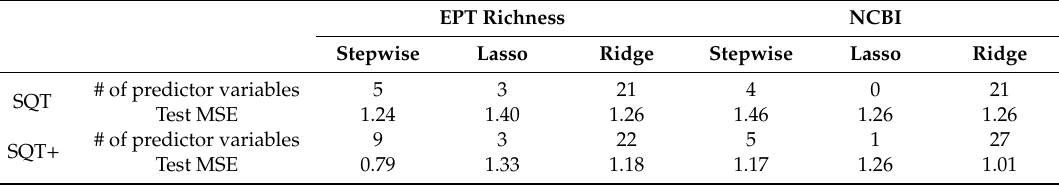
Number of predictor variables and test mean square error (MSE) results following cross-validation of stepwise, lasso, and ridge models used to predict EPT richness and the NCBI from two data sets (SQT and SQT +